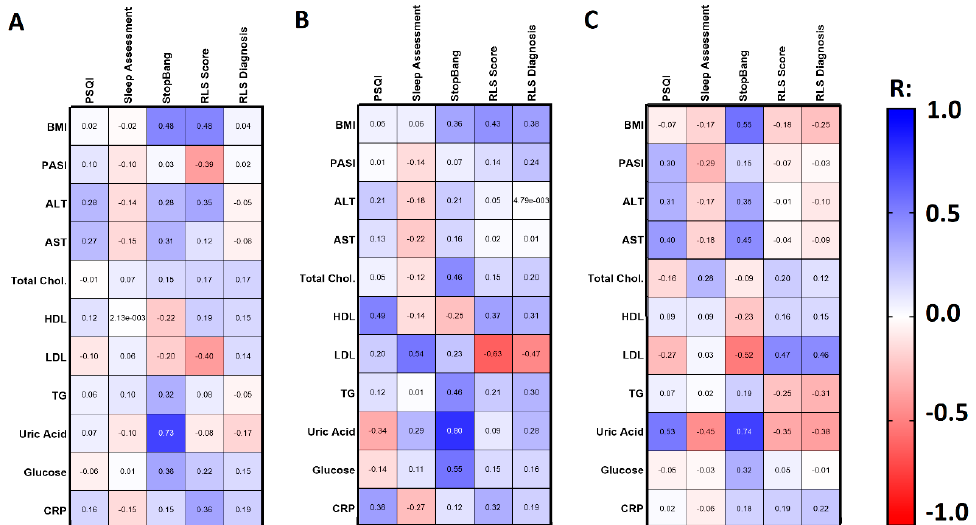
Figure 1. Assessment of PSQI ( A ) and subjective sleep assessment ( B ) in psoriatics and control groups. Graphs A-B present data shown as Mean ± SD and values are normally distributed. ***—means the existence of a statistically significant difference between values treatment with p < 0.0001. PSQI, Pittsburgh Sleep Quality Index. Data are shown as Mean ± SD or Contingency Graph.